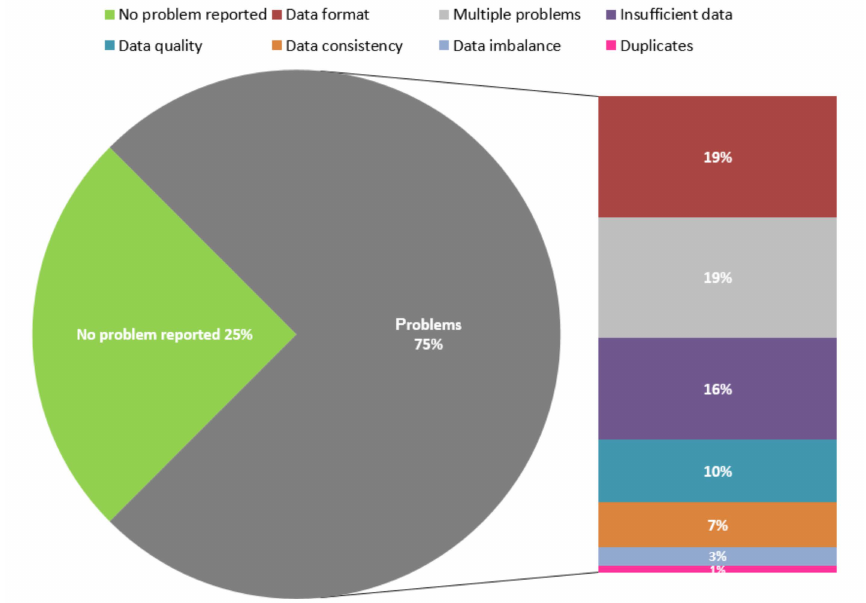
Figure 15. Frequency of challenges in open data utilization for all papers.